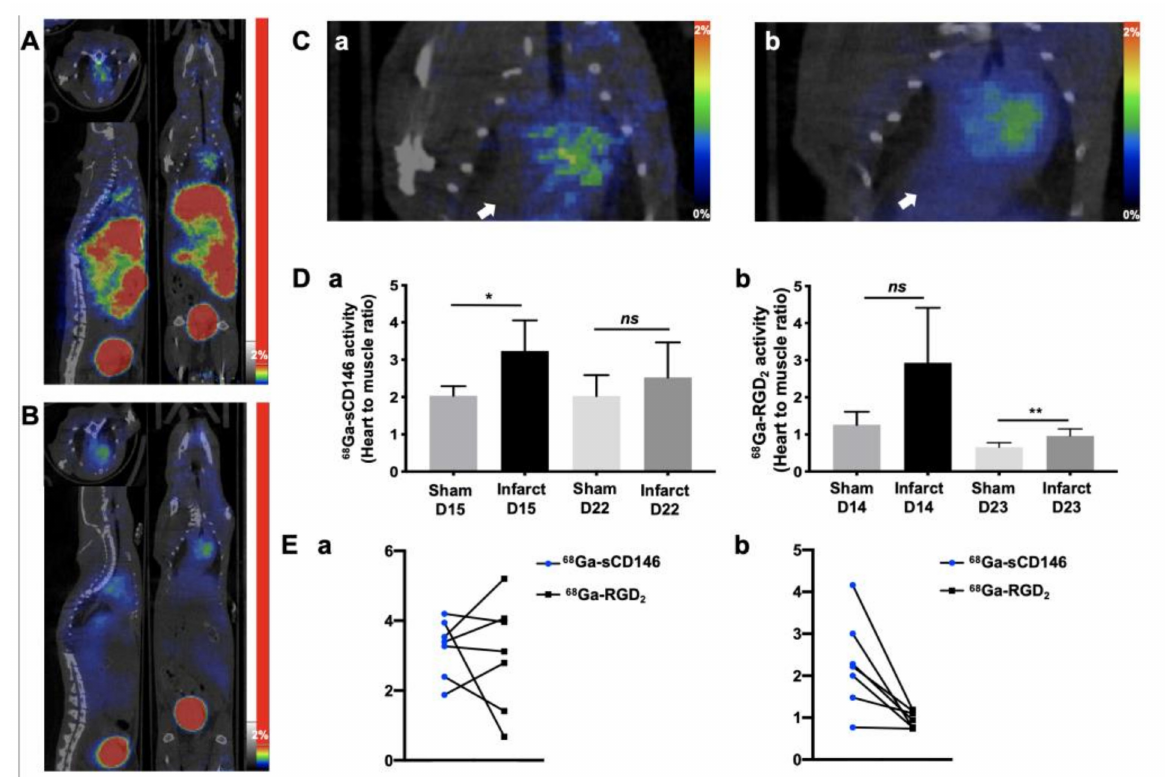
Figure 4. AMOT expression evaluated by 68 Ga-sCD146 microPET imaging was early increased after myocardial infarction. ( A ) Representative whole body PET images of 68 Ga-sCD146 on infarcted heart. ( B ) Representative whole body PET images of 68 Ga-RGD 2 on infarcted heart and PET imaging on infarcted heart. ( C ) Representative cardiac-focused images of 68 Ga-sCD146 ( a ) and 68 Ga-RGD 2 ( b ) PET imaging on infarcted heart. White arrow indicates the infarcted myocardium area. ( D ) Semi-quantitative analysis of 68 Ga-sCD146 PET uptake ( a ) expressed as heart-to-muscle ratio, showed an early and significant increase in infarcted hearts at day 15 compared to sham hearts (H/M ischemic = 3.23 ± 0.82, n = 7, H/M sham = 2.03 ± 0.25, n = 4; * p = 0.04) and a trend of increasing uptake at day 22 post-surgery (H/M ischemic 2.52 ± 0.94, n = 7; H/M sham = 2.02 ± 0.56, n = 4; ns: p = 0.30). Semi-quantitative analysis of 68 Ga-RGD 2 PET uptake ( b ), expressed as heart-to-muscle ratio, showed a delayed but significant increase in the infarcted heart compared to sham hearts at day 23 post-surgery (H/M ischemic = 0.96 ± 0.18, n = 7, H/M sham = 0.65 ± 0.12, n = 4; p = 0.02). No uptake modification was observed before this time (H/M ischemic = 2.92 ± 1.48; H/M sham = 1.26 ± 0.13, n = 7, ns: p = 0.15 at day 14 post-myocardial infarction). ( E ) Semi-quantitative intra-animal comparison of both tracers, 68 Ga-sCD146 and 68 Ga-RGD 2 at early times, respectively D14 and D15 after MI surgery ( a ). No significant difference was observed between 68 Ga-sCD146 and 68 Ga-RGD 2 PET uptake in the infarcted heart at this time (n = 7; p = 0.93). Semi-quantitative intra-animal comparison was also realized